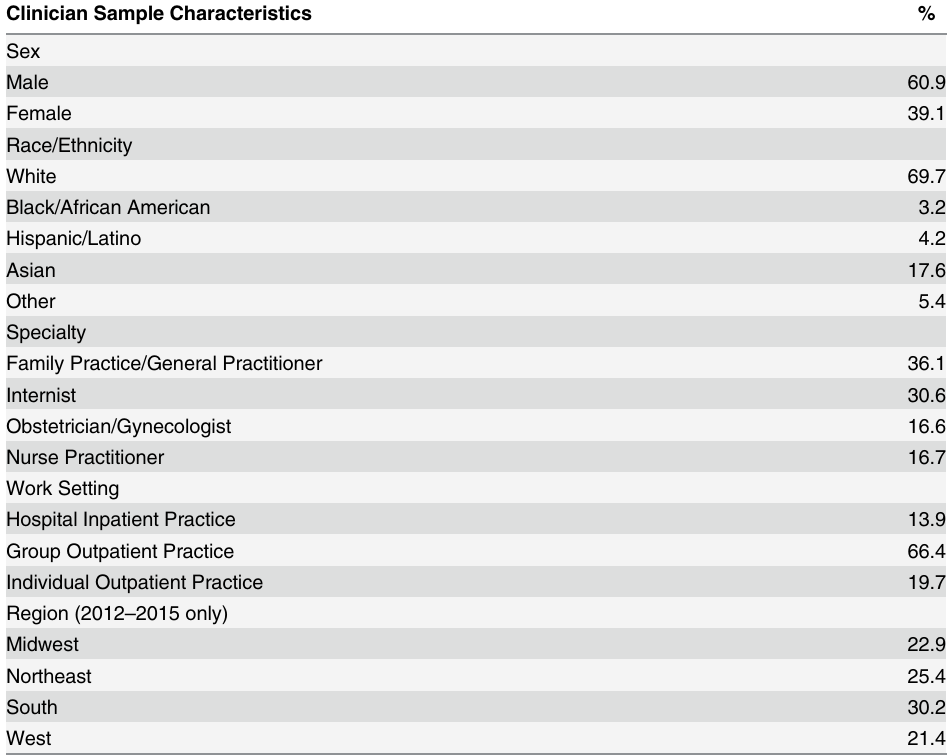
Table 2. Clinician Sample Characteristics, DocStyles, 2009 – 2015, United States. Total Sample Size (2009 – 2015) N = 9023. Clinician Sample